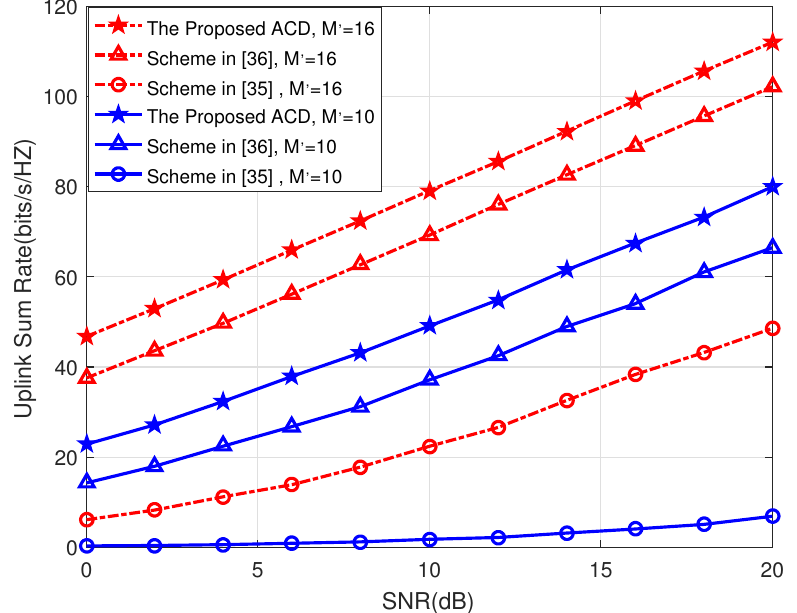
Figure 4. Uplink sum rate versus SNR, where M (cid:48) =